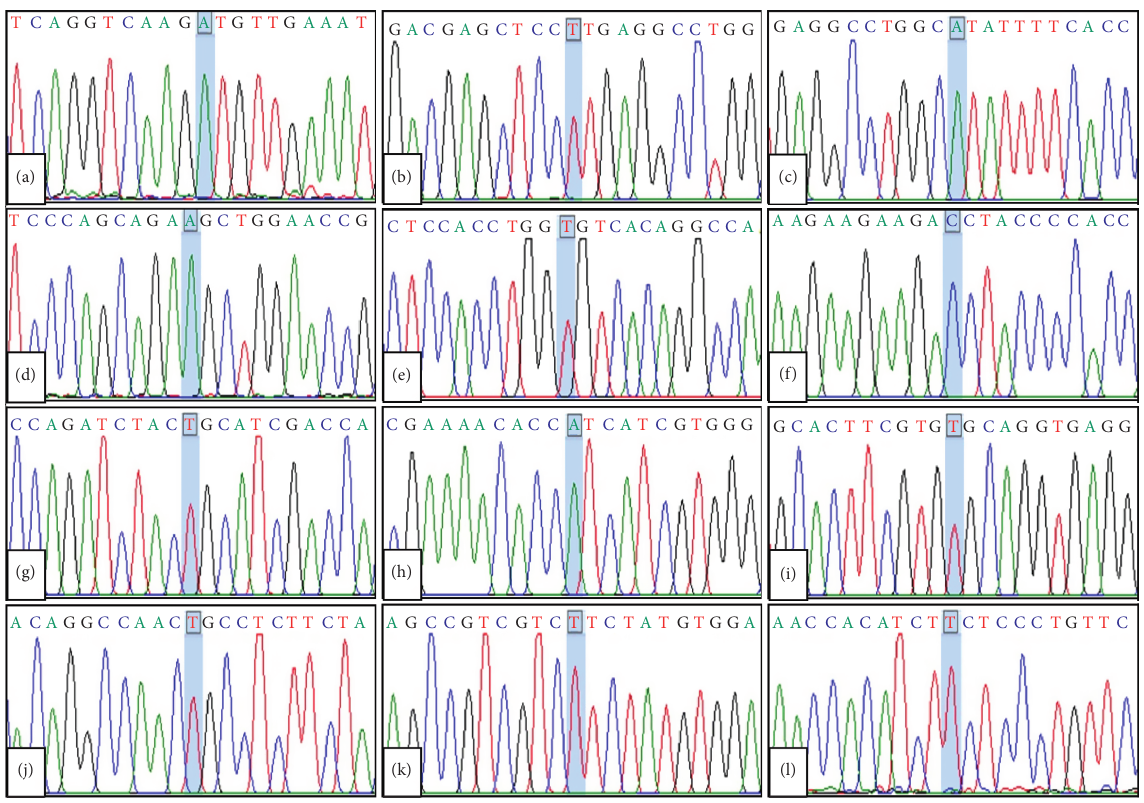
Figure 1: Electropherogram of 12 G6PD mutations identified in this study; (a) G6PD Viangchan (c.871G > A, p.Val291Met), (b) G6PD Canton (c.1376G > T, p.Arg459Leu), (c) G6PD Kaiping (c.1388G > A, p.Arg463His), (d) G6PD Mahidol (c.487G > A, p.Gly163Ser), (e) G6PD Quing Yan (c.392G > T, p.Gly131Val), (f) G6PD Aures (c.143T > C, p.Ile48Thr), (g) G6PD Coimbra (c.592C > T, p.Arg198Cys), (h) G6PD Songklanagarind (c.196T > A, p.Phe66Ile), (i) G6PD Union (c.1360C > T, p.Arg454Cys), (j) G6PD Valladolid (c.406C > T, p.Arg136Cys), (k) G6PD Chinese-5 (c.1024C > T, p.Leu342Phe), and (l) G6PD Mediterranean (c.563C > T,